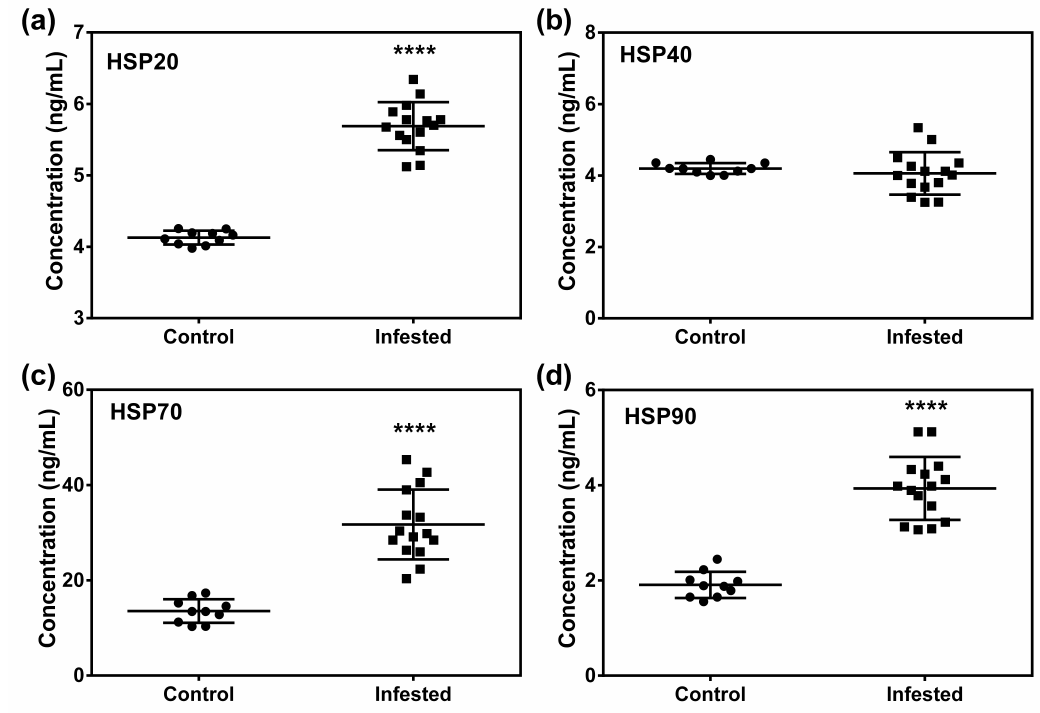
Figure 7. E ff ect of crusted scabies on serum heat shock proteins (HSPs) concentration in a porcine model. ( a ) HSP20, ( b ) HSP40, ( c ) HSP70, and ( d ) HSP90.Data in scatter plot are shown as mean ± SD. t -test was performed to find out significant di ff erence between the two groups. **** denotes p ≤